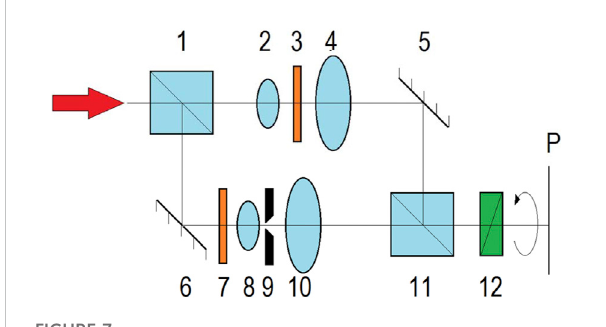
FIGURE 7 Arrangementfor theexperimental investigation of vortices ofthe planar polarization projectionsof an optical fi eld (1,11) beam-splitters; (2)micro-objective;(3)Te fl on(PTFE)plate;(4)objective;(5,6)mirrors; (7) quarter-wave plate; (8, 9, 10) beam expander; (12) analyzer.